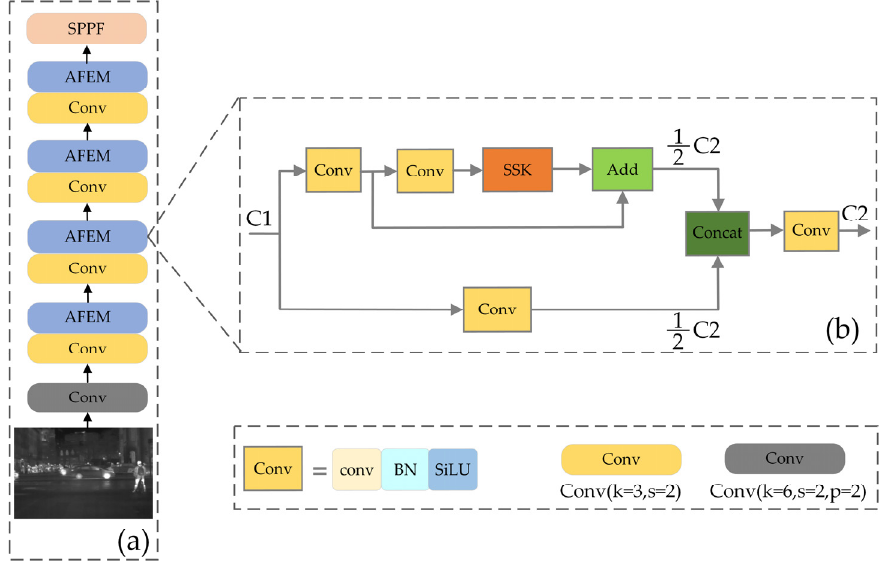
Figure 5. The specific structure of backbone and AFEM block: ( a ) structure of the IPD-Net backbone; ( b ) structure of the AFEM.